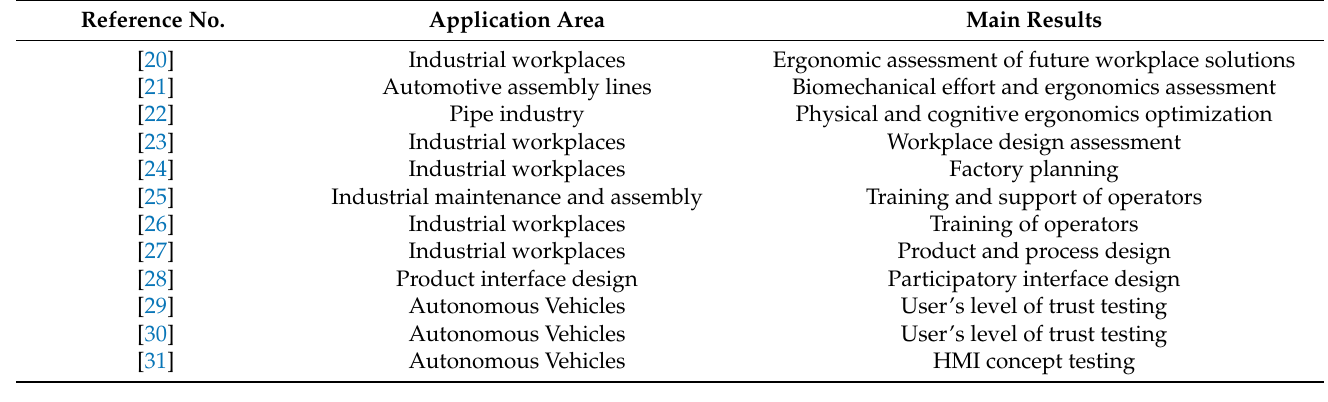
Table 1. Contributes from literature.